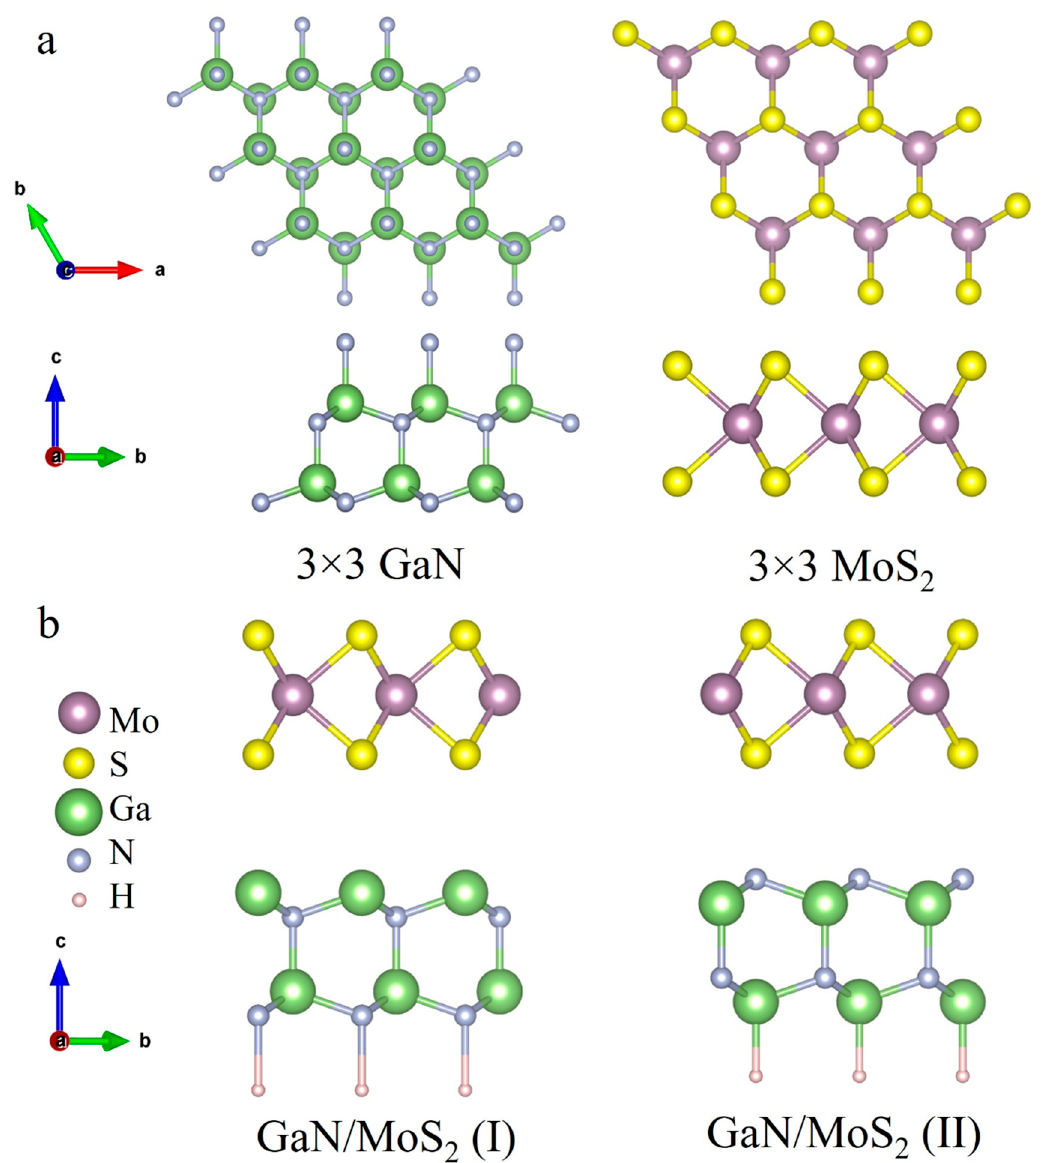
Figure 1. ( a ) Top and side views of 3 × 3 MoS 2 monolayer and 3 × 3 GaN supercells. ( b ) Side views of GaN/MoS 2 (I) and (II) heterostructures based on Ga-polarity and N-polarity surfaces, respec- tively.